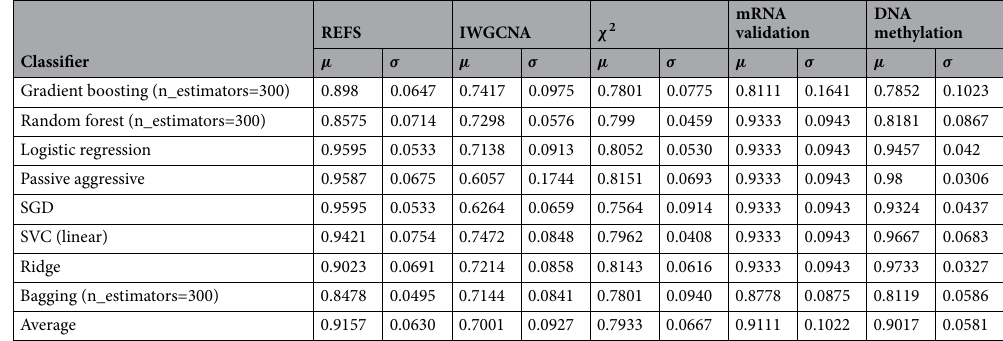
Table 1. Classification accuracy of the 23 predictor genes obtained with REFS, the 20 genes obtained with IWGCNA, and the 23 genes obtained with univariate analysis based on the same mRNA expression data of 118 samples from the CAMDA dataset Classification accuracy of eighteen of the 23 predictor genes applied to a validation mRNA dataset (GSE14577), and of 48 predictor CpGs obtained with REFS based on merged DNA methylation data. µ , mean; σ , standard